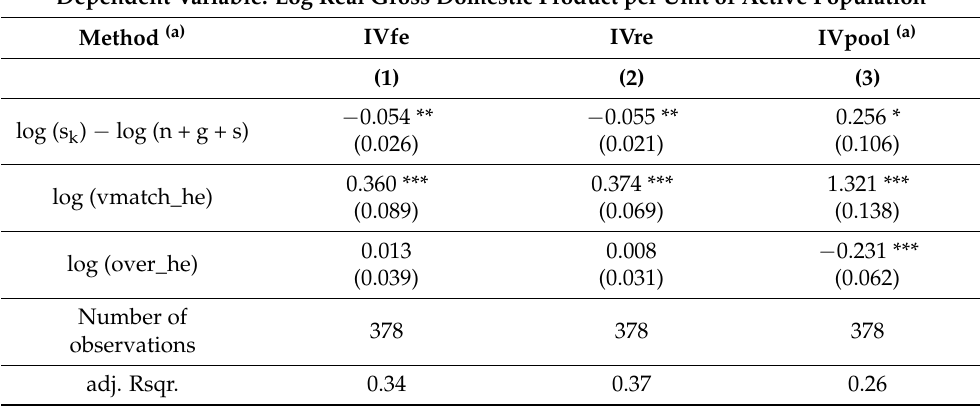
Table 3. Effect of vertical (mis)match of tertiary education graduates on per capita income.